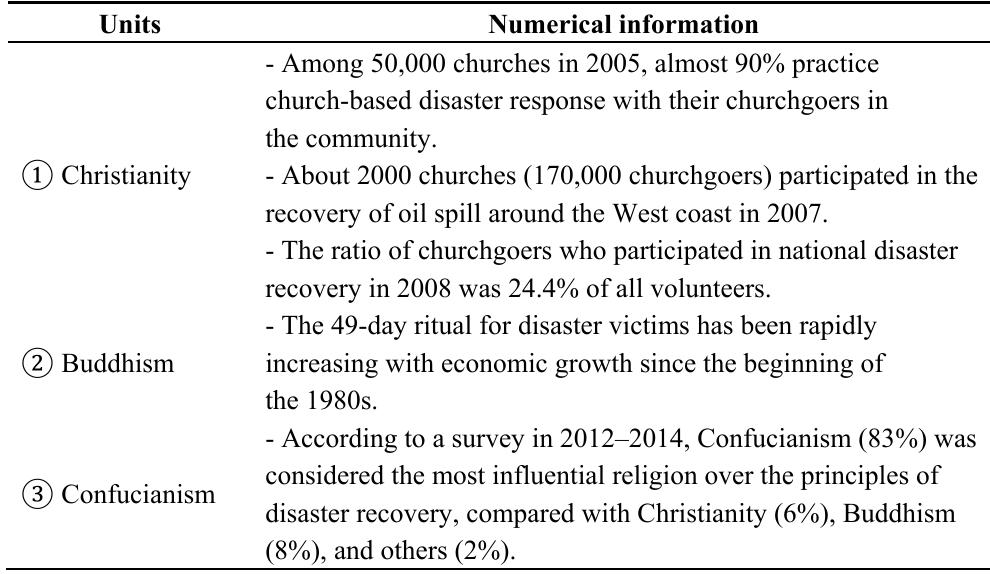
Table 1. Major numerical data on care-oriented